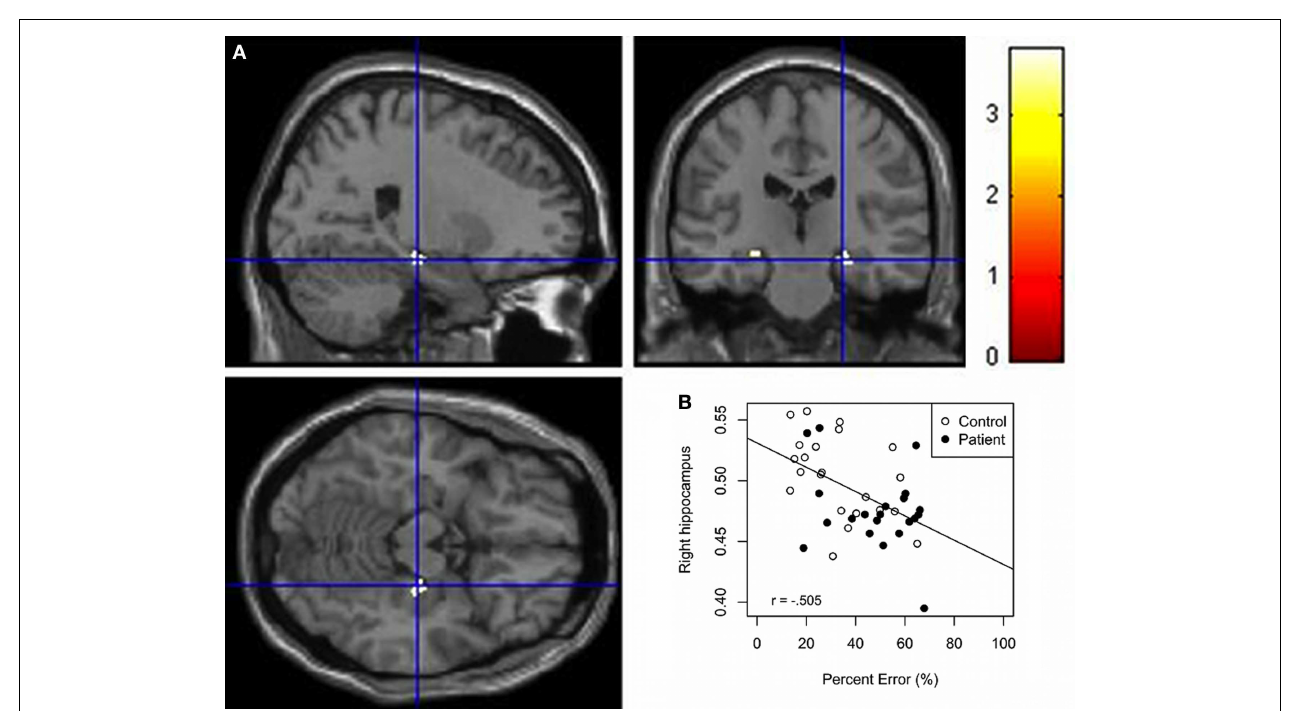
at seed voxel (24, − 21, − 15; p < 0.001) with Percent error on the wayfinding task. Pearson correlation between right hippocampus GM and percept error for the control group ( r =− 0.484, p = 0.01) and patient group ( r =− 0.318, p =